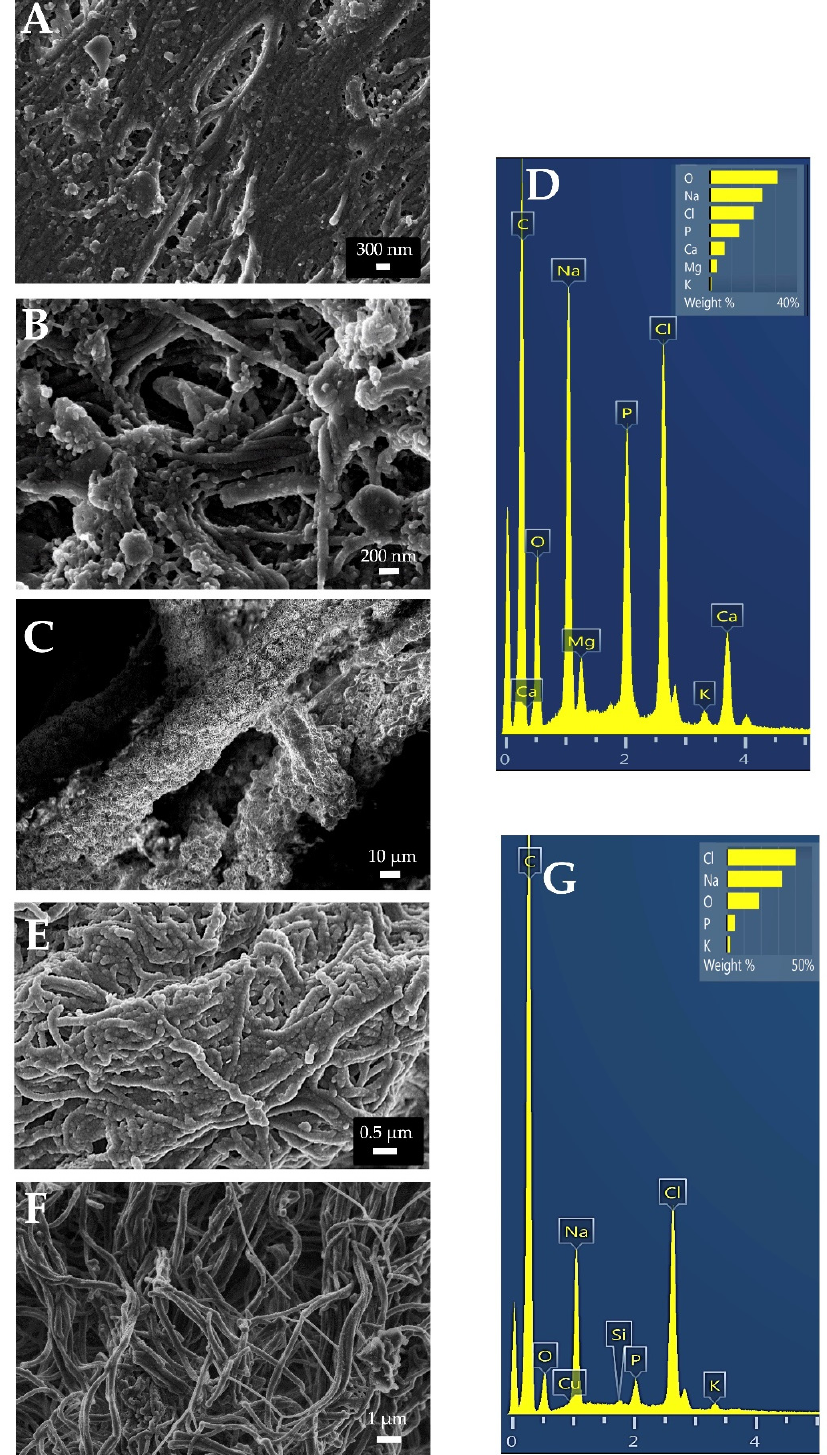
Figure 4. SEM images taken from the three membranes after 21 d of SBFS immersion. ( A – C ) Derma, ( D ) EDS spectrum from Derma membrane showing calcium and phosphate presence. ( E , F ) Evolution, ( G ) EDS spectrum from Evolution membrane. Randomly distributed collagen fibrils are found in all the membrane types. Some zones evidencing rounded deposits for both membranes are shown. At EDS analysis, elements such as C or O can be detected for their presence, but cannot be quantified reliably. Images have different magnifications (1000× to 50,000×).